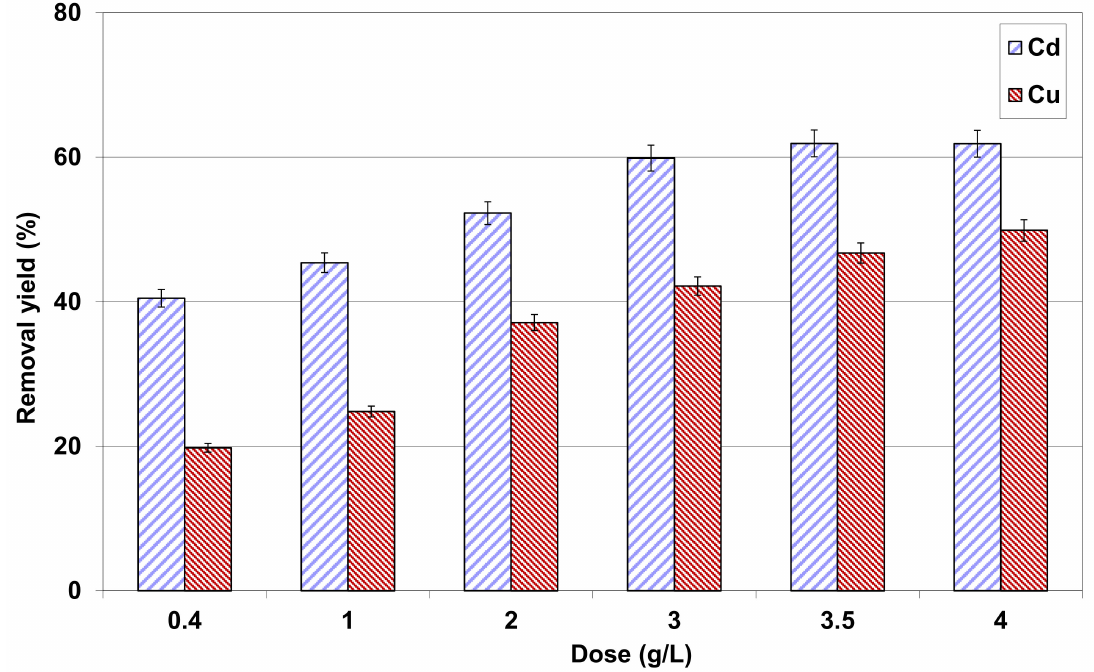
Figure 4. Impact of lignite dose on Cd and Cu removal yields (C 0 = 100 mg L − 1 , t = 60 min; pH = 5; T = 20 ± 2 ◦